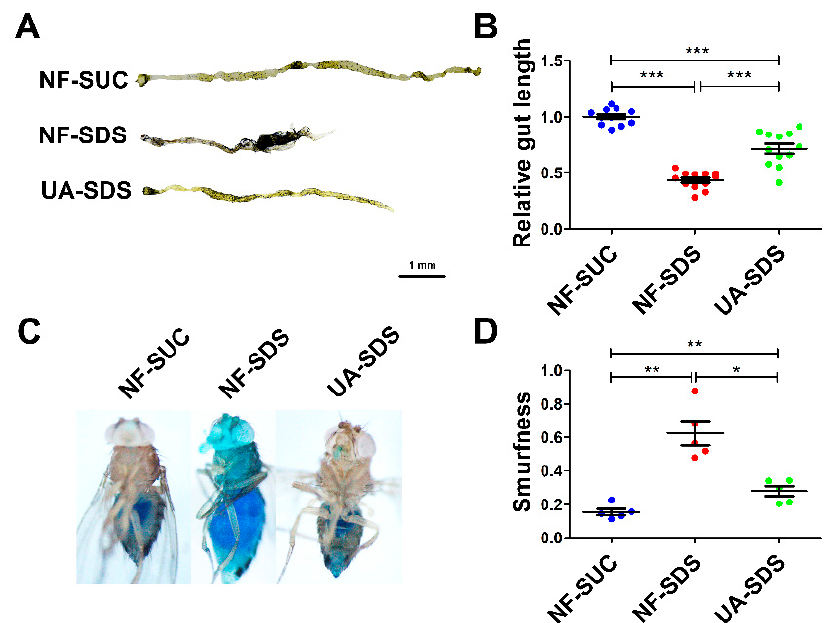
Figure 2. UA alleviated SDS-induced impairment of intestinal morphology and barrier integrity. ( A ) After exposure to 0.5% SDS for 48 h, the intestines of these flies (NF-SDS) appeared shorter than control (NF-SUC), UA significantly increased the intestine length. ( B ) Quantitative measurement of ( A ) (n ≥ 10). ( C ) A small amount of blue dye occurred in the gut of control flies (NF-SUC) while the blue dye escaped throughout the whole body of UC model flies exposed to 0.5% SDS for 48 h (NF- SDS), which can be prevented by pre-feeding of UA (UA-SDS). ( D ) The intestinal barrier permeability was quantified by measuring the Smurfness (n = 5). * p < 0.05, ** p < 0.01, *** p < 0.001.